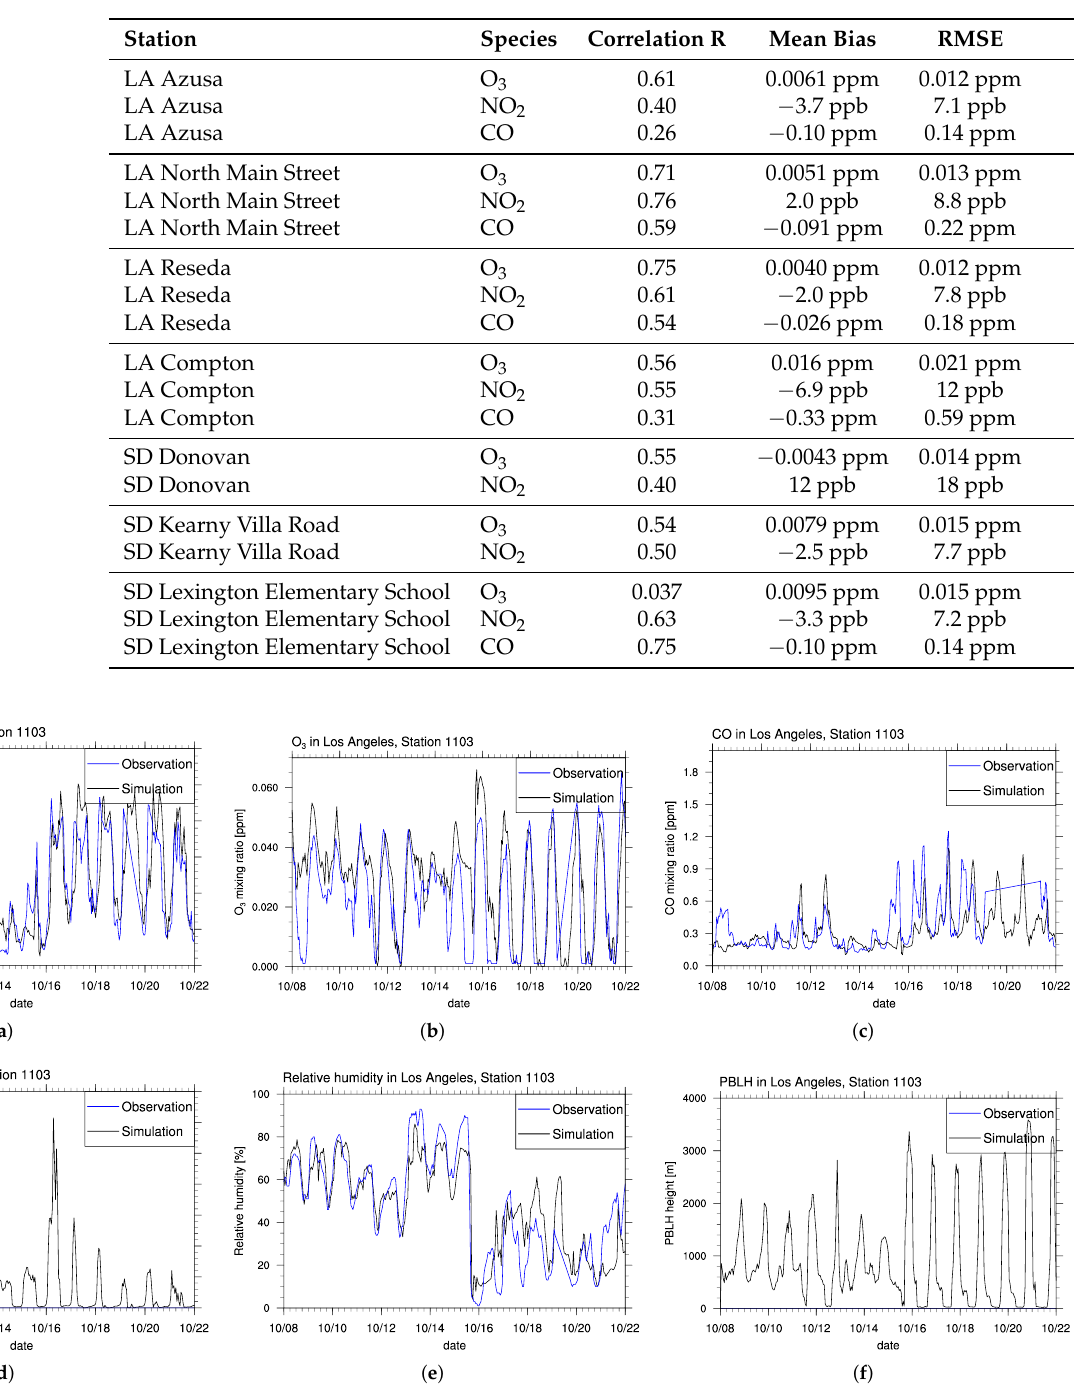
Table 4. Statistics of observed and simulated concentrations of O 3 , NO 2 , and CO from 8–22 October 2018.